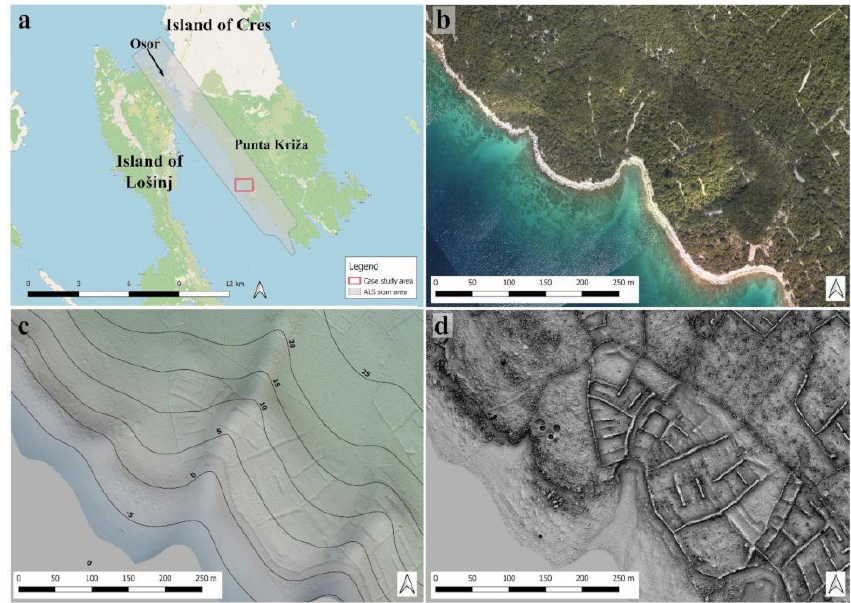
Figure 2. ( a ) Map of the total area of ALS data capture and the case study area (red box). ( b ) Orthophotograph of the case study area produced simultaneously with ALS data acquisition (March 2012). ( c ) Contour lines at 5 m intervals calculated based on low pass filtered digital feature model (DFM; r = 20 m). The zero-contour marks the coastline. ( d ) Filtered DFM (visualization: